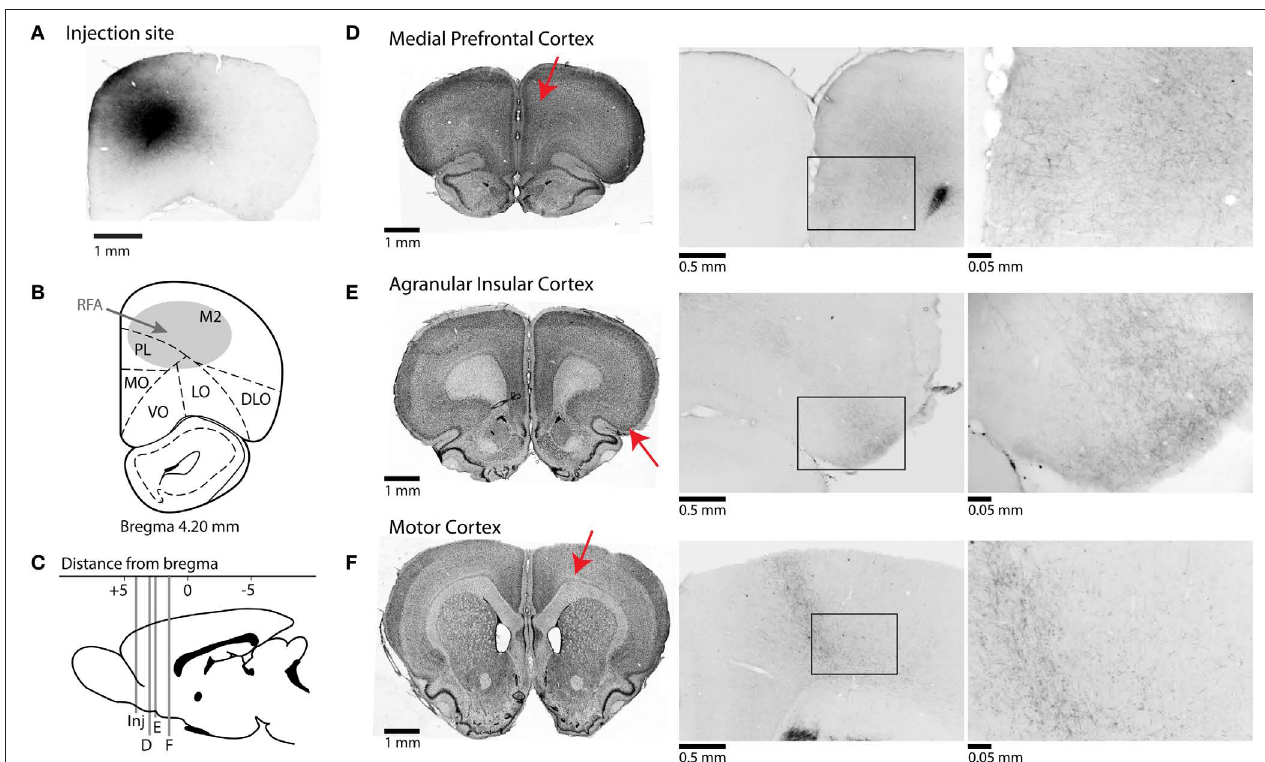
sections shown on left represent coronal slices to which BDA-stained sections in middle and right sections correspond. Photomicrographs in center are taken at 4 × magnification, and at right at 40 × magnification. (D) RFA projects to areas of anterior cingulate cortex and prelimbic cortex, and fibers are seen in superficial layers of prelimbic at higher magnification. (e) Connections to agranular insular cortex are seen at high magnification across superficial and deeper layers of cortex. (F) Projections are found in deeper layers of primary motor